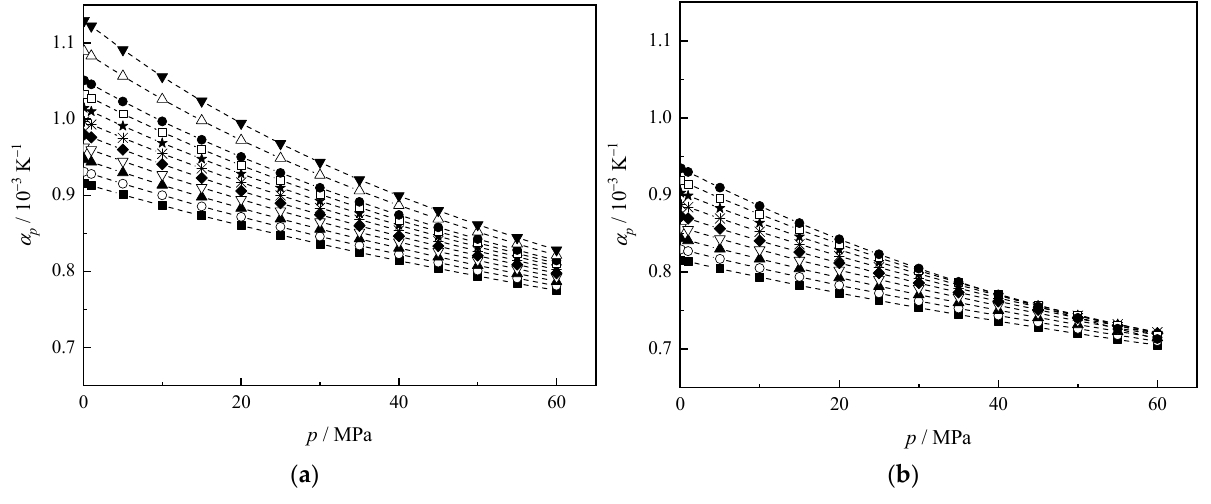
Qureshi et al. [17] and Baird et al. [23] are of the same order of magnitude as the uncer- The measurement uncertainties reported by Zaoui-Djelloul-Daouadji et al. [14],